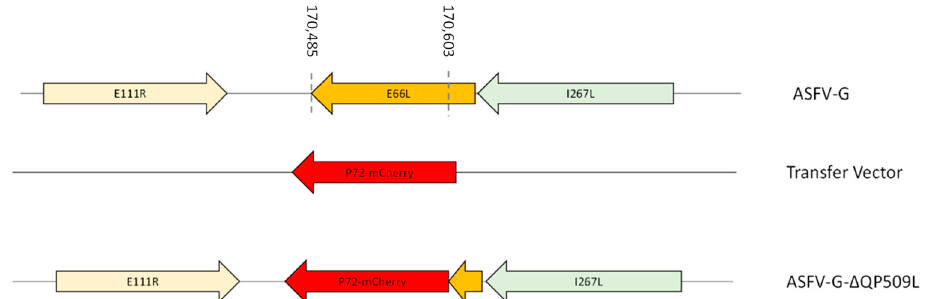
Figure 2. Schematic for the development of ASFV-G- ∆ E66L. The transfer vector contains the p72 promoter and an mCherry cassette; the flanking left and right arms are indicated. They were designed to have flanking ends to both sides of the deletion/insertion cassette. The nucleotide positions of the ASFV-G genome are indicated. The resulting ASFV-G- ∆ E66L virus with the cassette inserted is shown on the bottom.